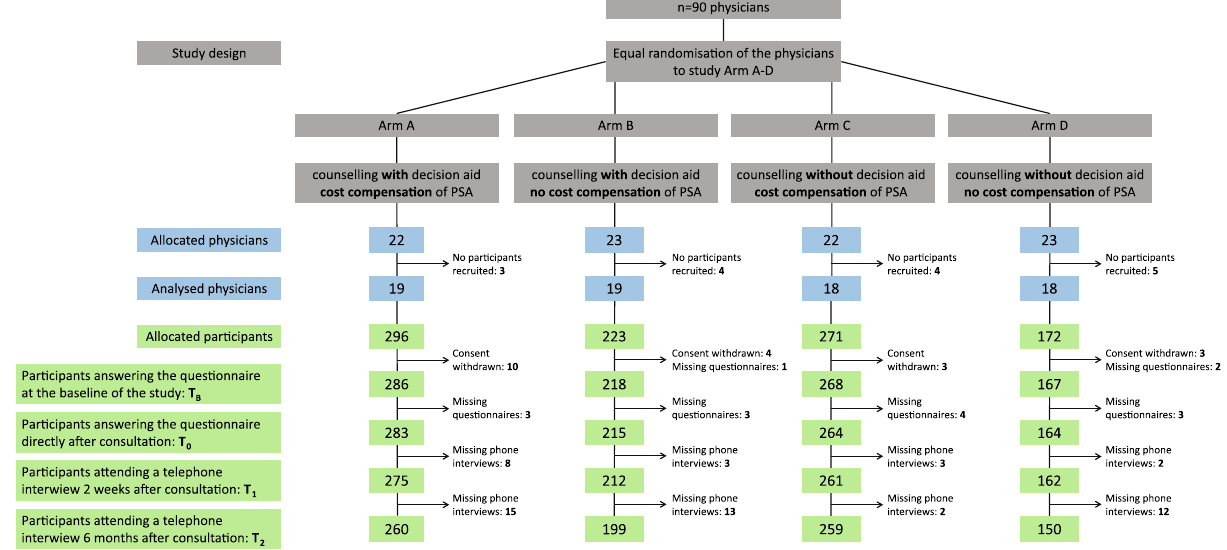
Figure 2. CONSORT flow diagram of the cluster-randomised controlled trial “PSAInForm” with a 2 × 2 factorial design. 90 physicians are randomised to one of four arms (A-D) before they start to recruit participants. PSA = prostate specific